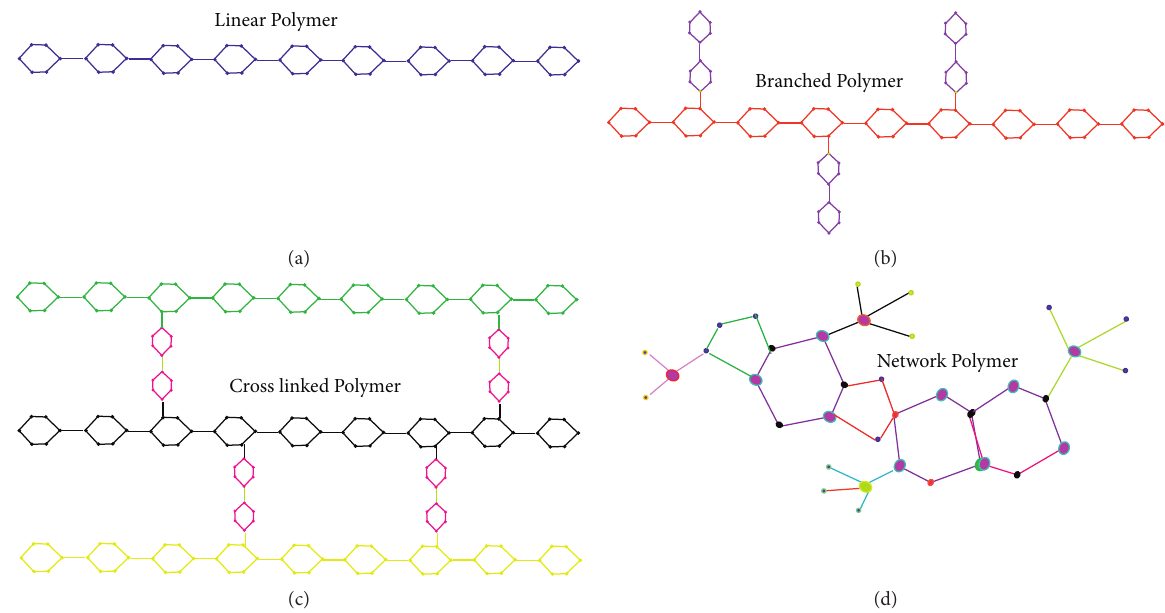
Figure 1: Polymer characterization with regard to structural